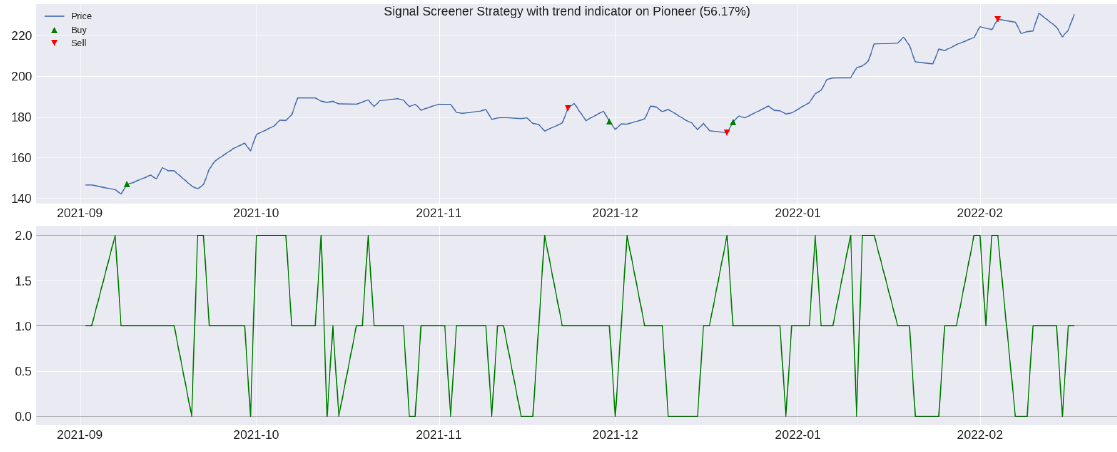
Figure 10. Operations of TI-SiSS over the test period of Pioneer Natural Resources